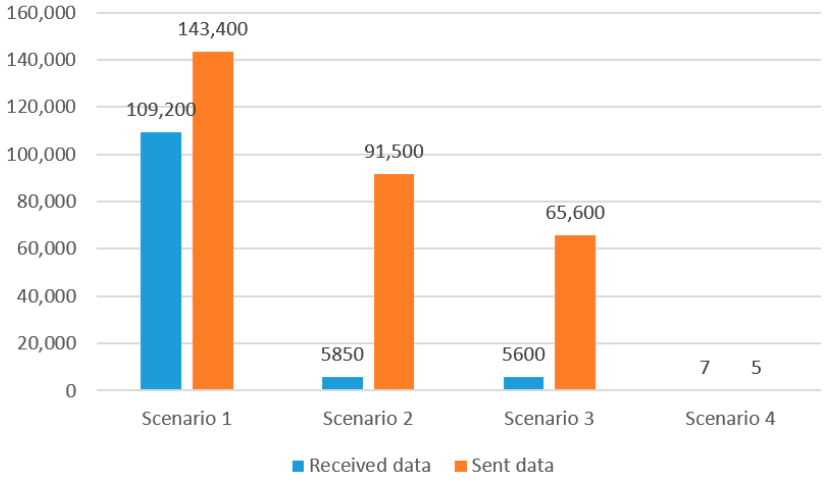
Figure 11. Comparison of sent/received traffic values across all four study scenarios.